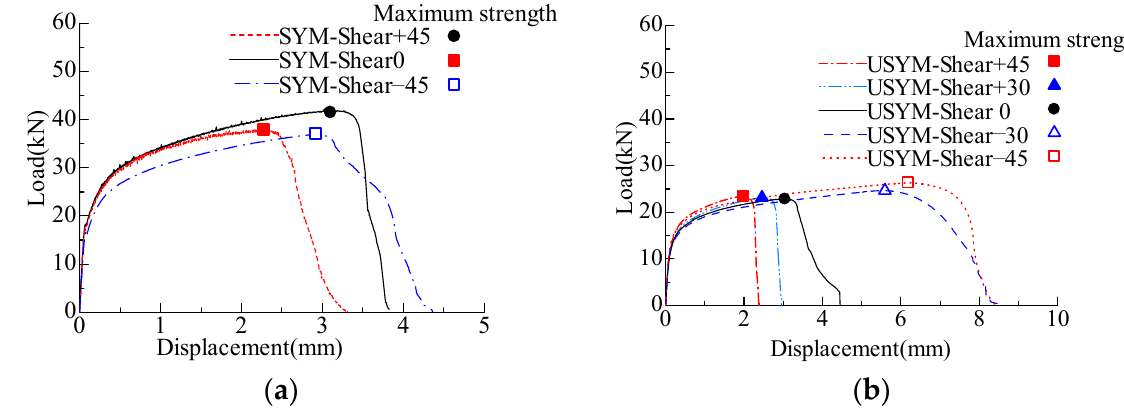
Figure 8. Load-displacement curves of SM490 steel: ( a ) SYM-Shear specimens; ( b ) USYM-Shear specimens.